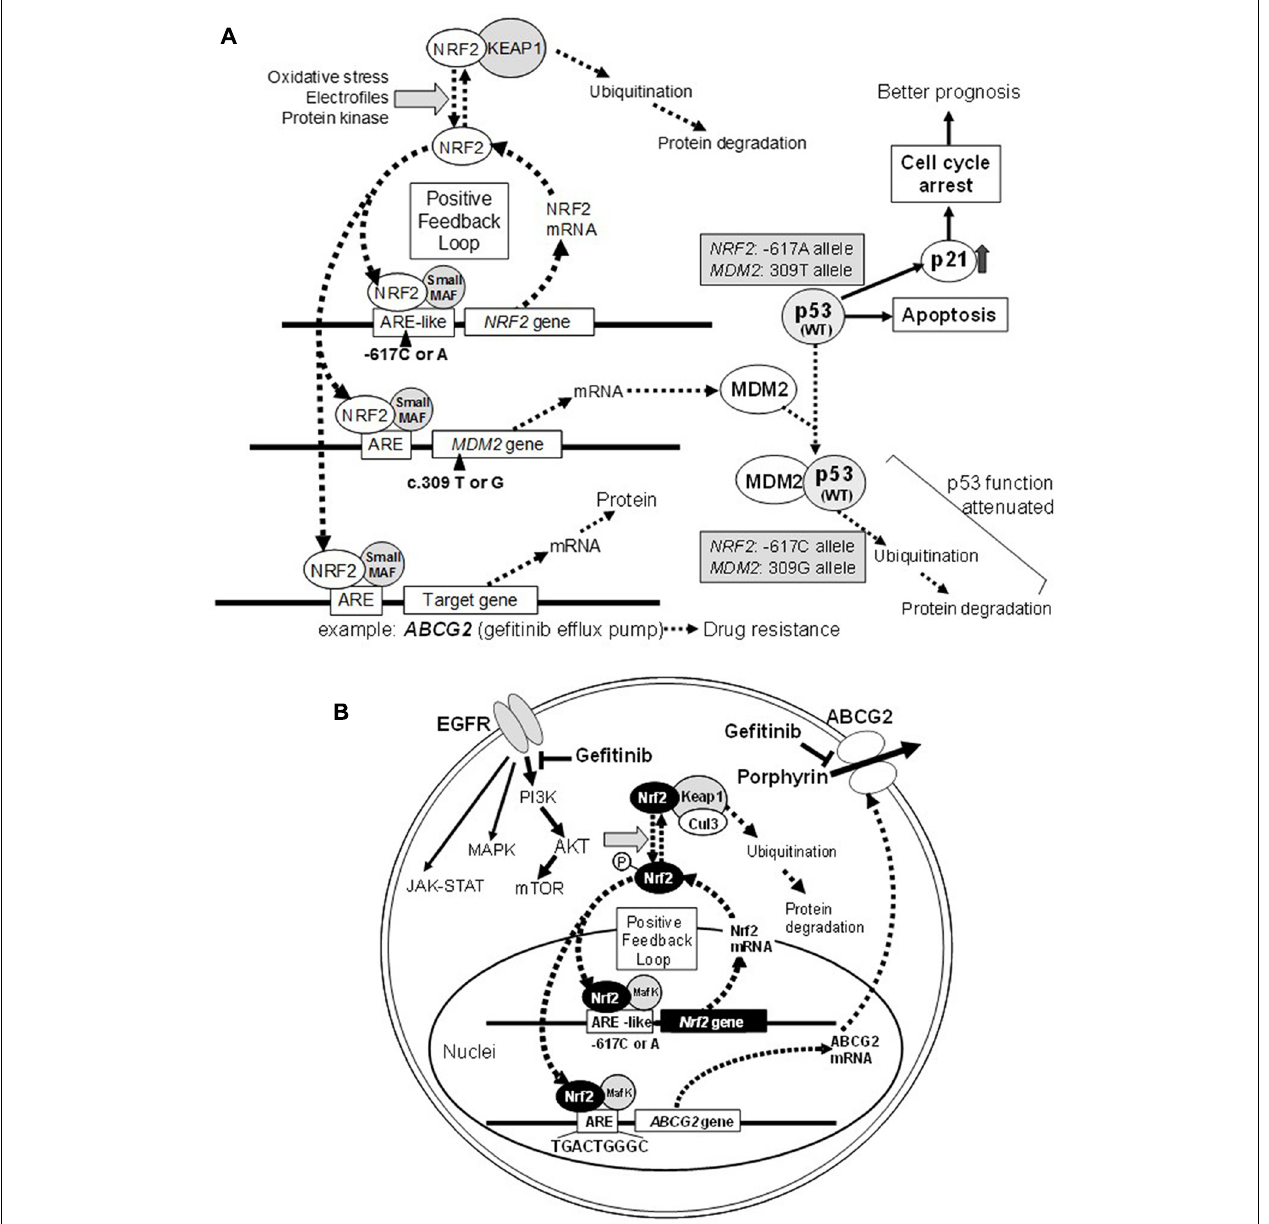
FIGURE 1 | Schematic illustrations showing the effect of NRF2 SNP − 617C > A and MDM2 SNP c. 309T > G on the p53-mediated suppression of cancer cell proliferation (A) andABCG2-mediated drug resistance to gefitinib (B). Refer to Okano etal. (2013) for more details.